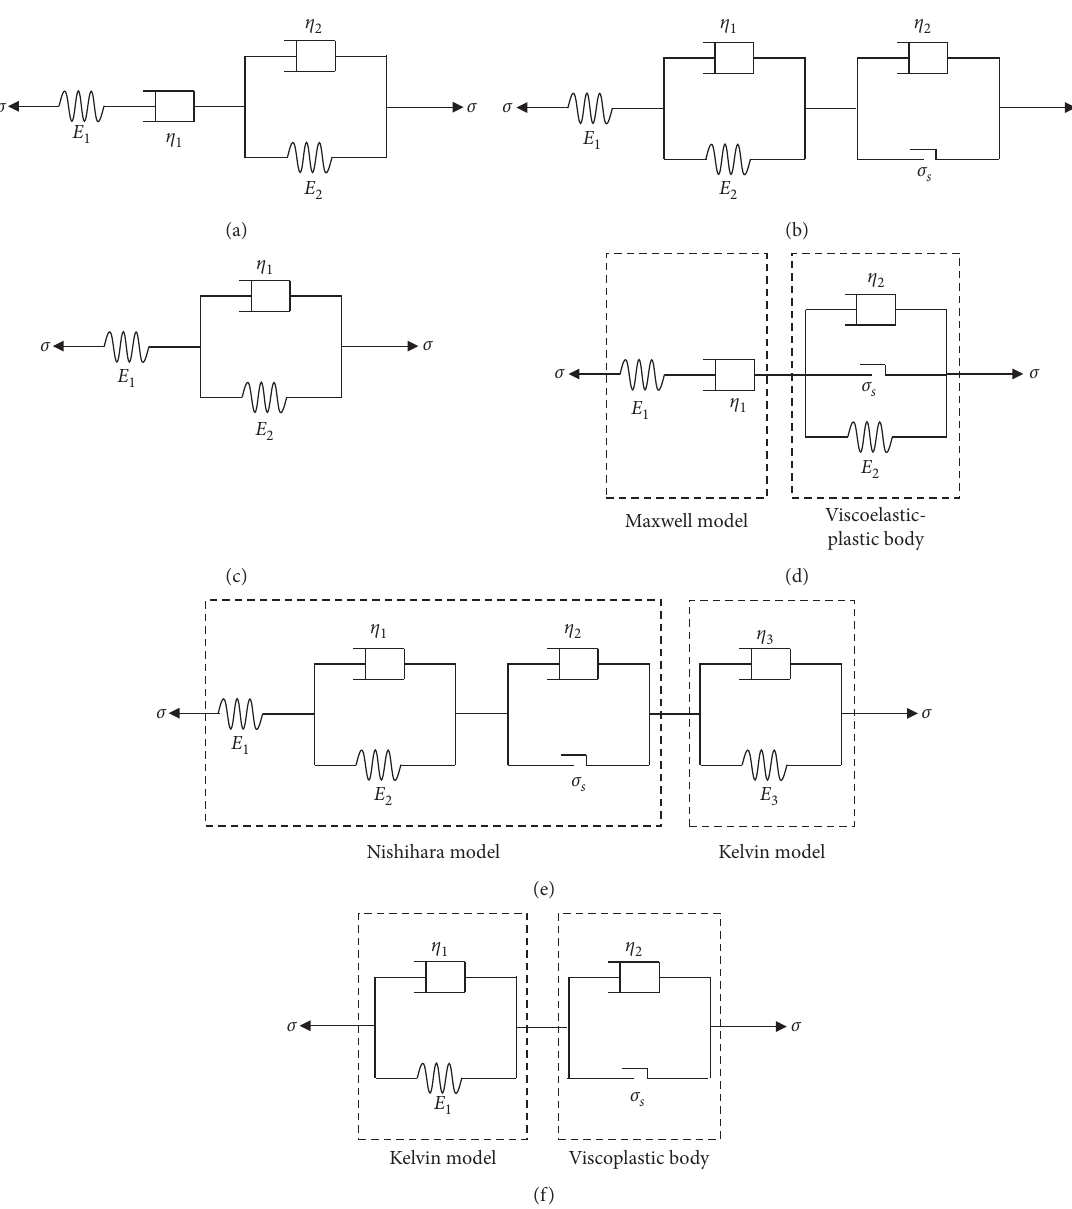
Figure 10: Schematic diagrams of the component combination model commonly used. (a) Burgers model; (b) Nishihara model; (c) Generalized Kelvin model; (d) Maxwell body and viscoelastic-plastic body in series; (e) Nishihara model and Kelvin model in series; (f) Kelvin model and the viscoplastic body in